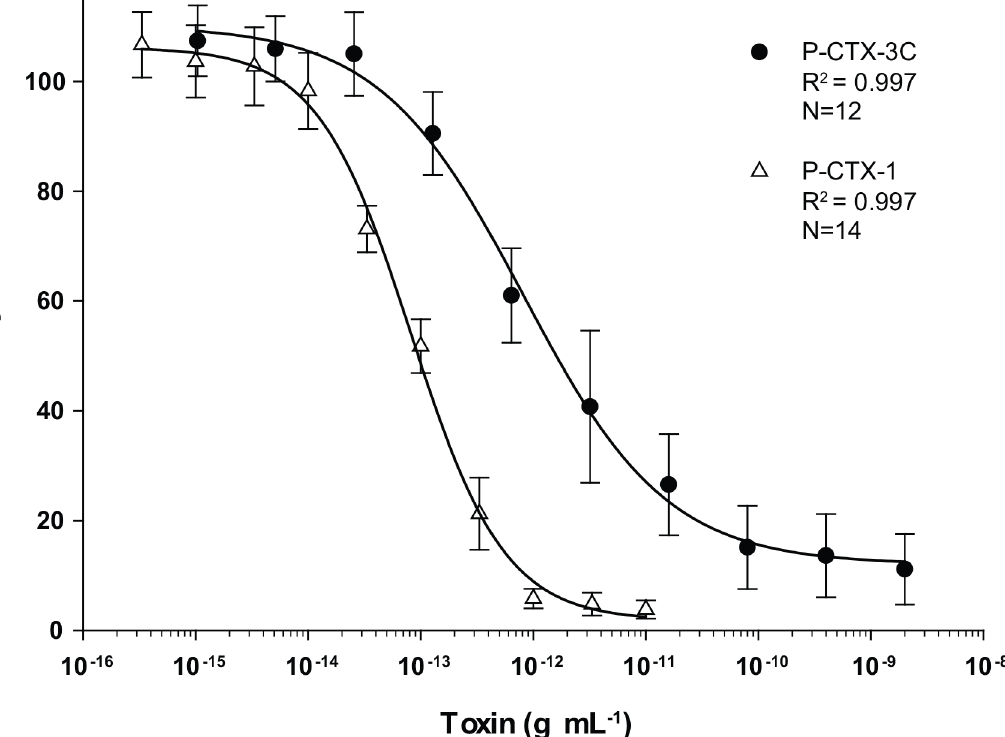
Fig 7. CBA-N2a Ciguatoxin Standard Curves. CBA-N2a standard curves for P-CTX-3C (closed circle) and P-CTX-1 (open triangle) with percent (%) viability of Neuro-2a plotted against toxin concentration (g mL -1 ). Percent cell viability is defined as the survival ratio of cells treated with and without ouabain and veratridine. Error bars represent ± standard deviations of multiple standard curves. The number of curves included is given as (N).